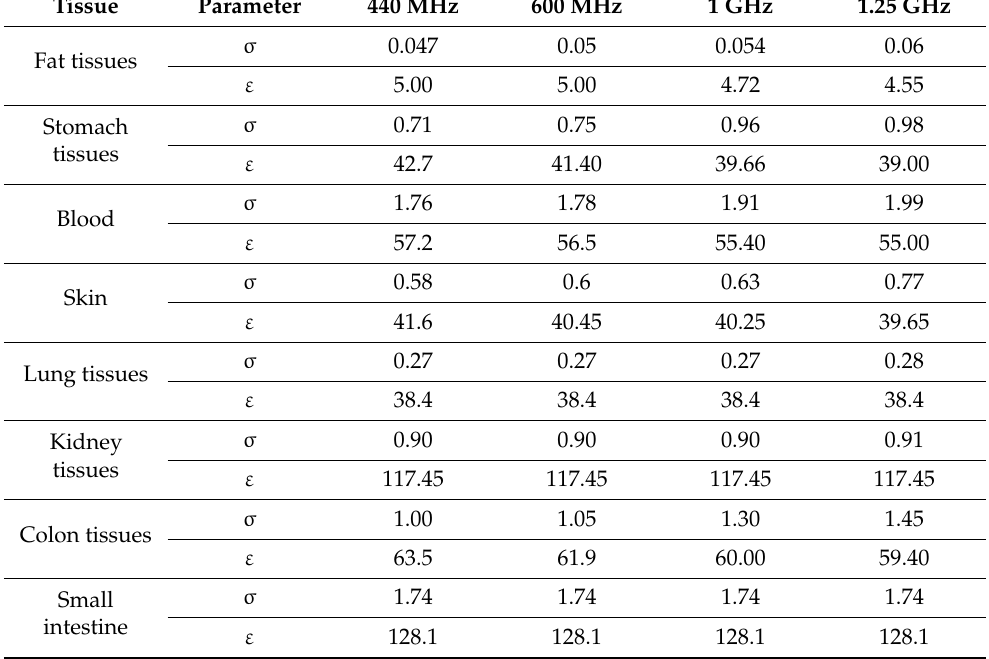
Table 9. Electrical parameters of human body tissues [16,17].